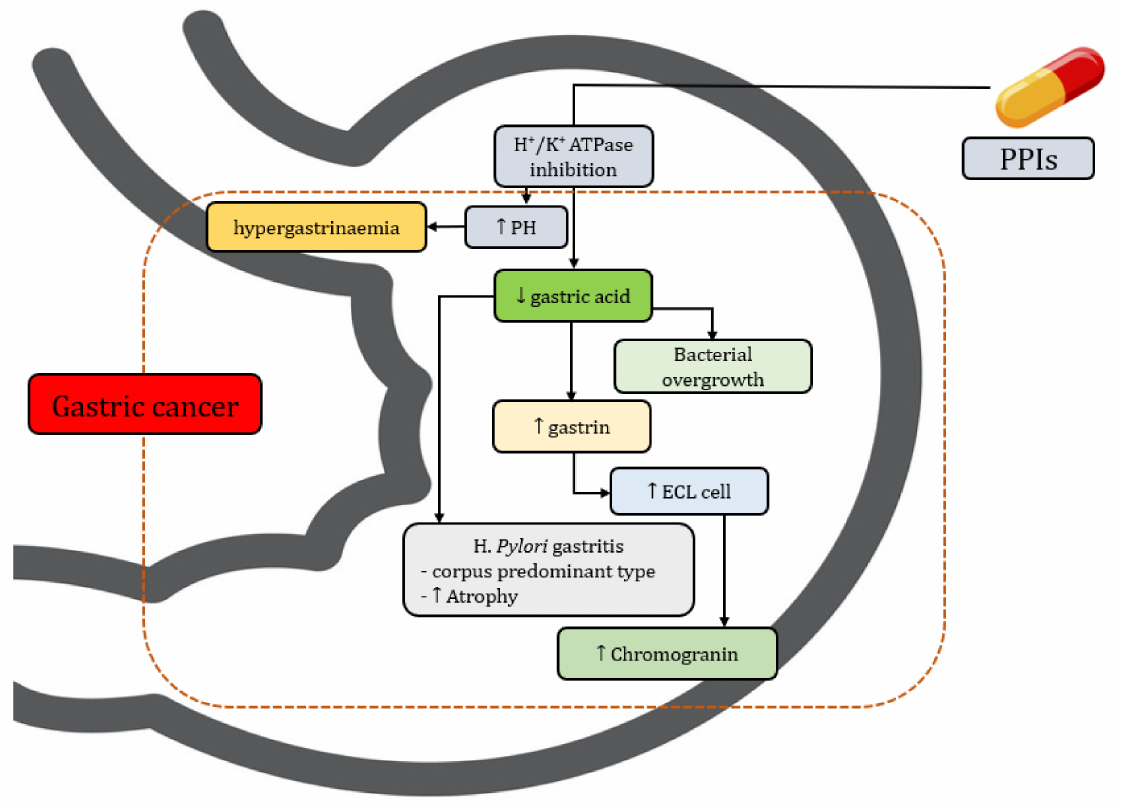
Figure 5. Biological mechanism of PPIs including gastric cancer ( ↑ = increase, ↓ =